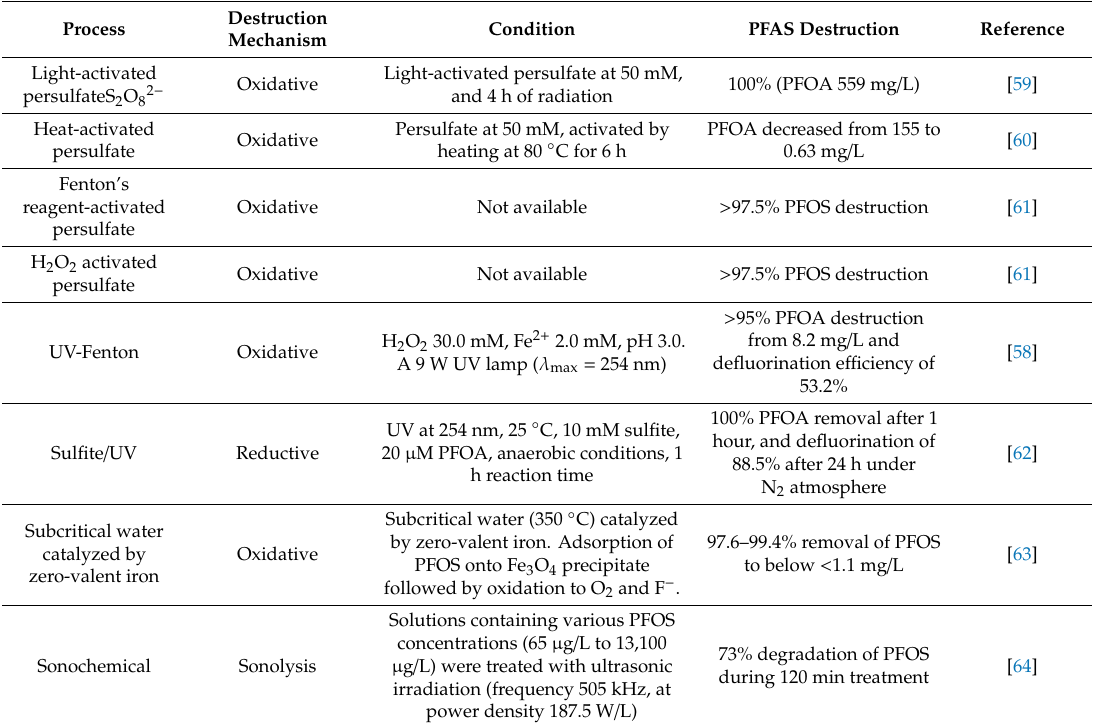
Table 1. Summary of laboratory-scale test results for selected treatment processes evaluated for PFAS